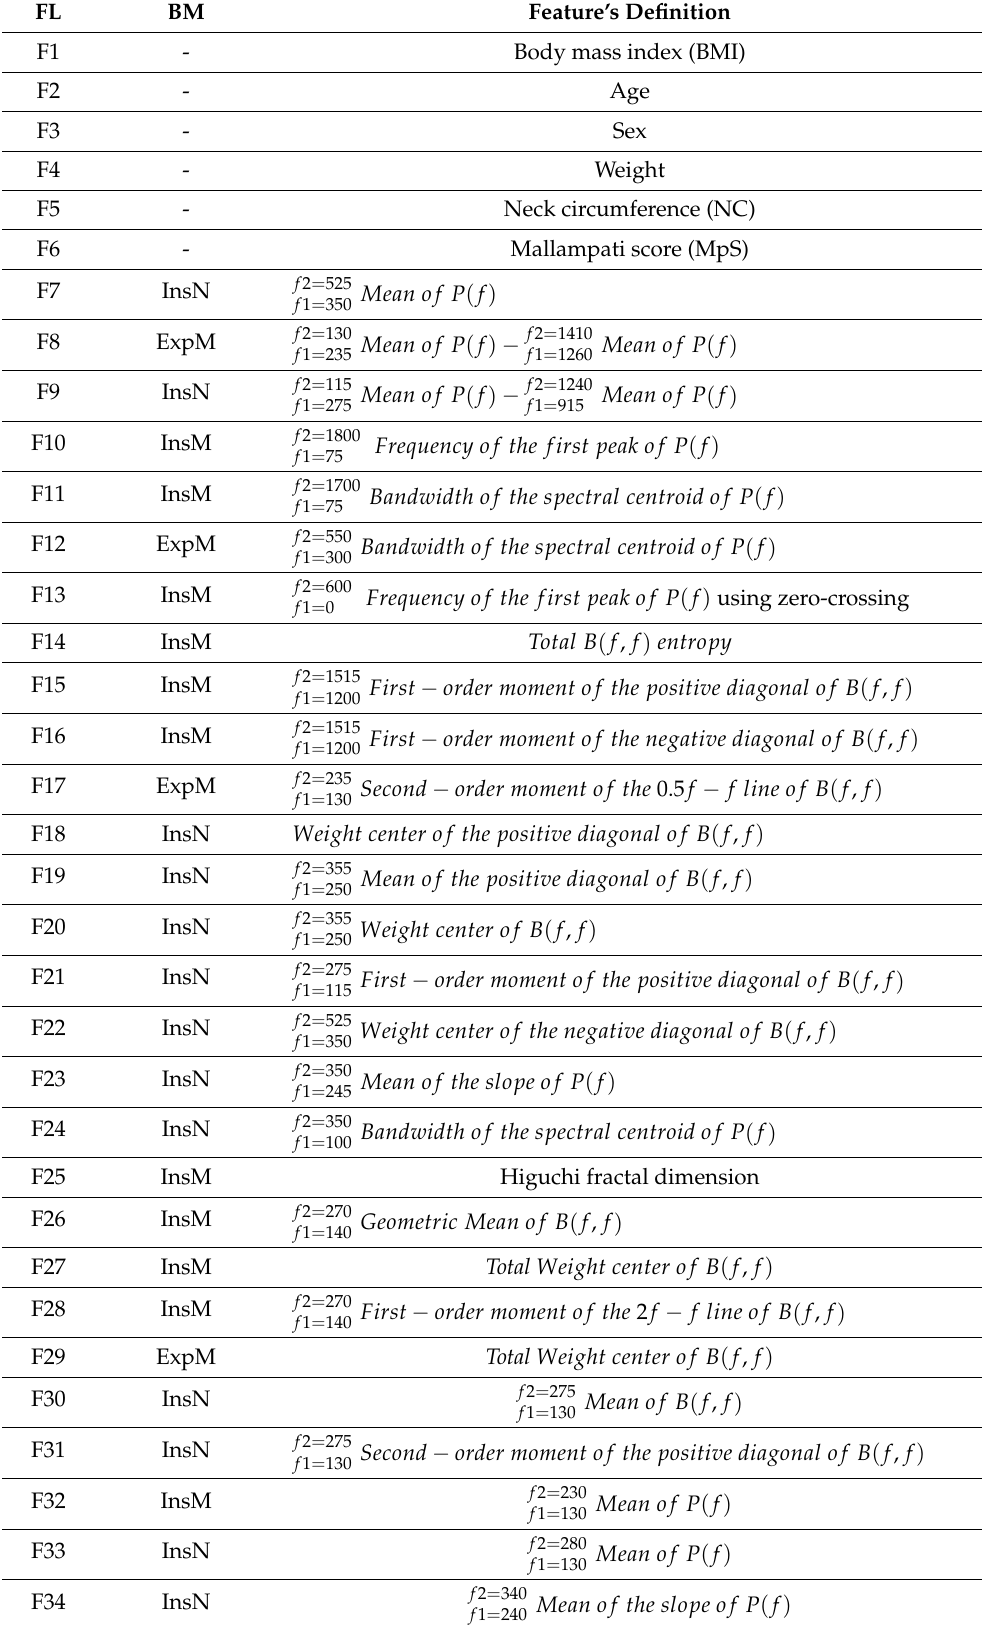
Table 1. Descriptions and details of the selected anthropometric and sound